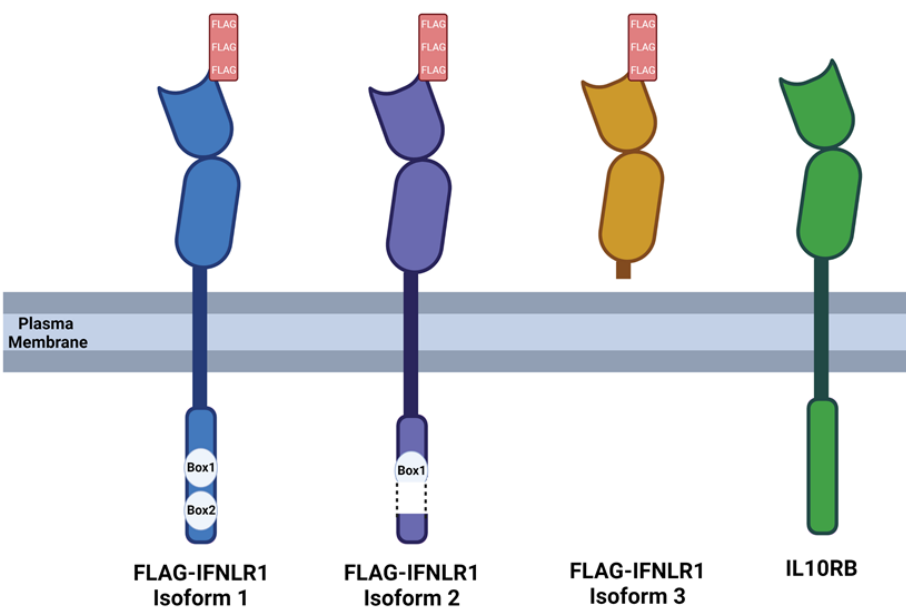
Figure 1. FLAG-IFNLR1 isoforms and co-receptor IL10RB. Schematic depicting the structure of each FLAG-tagged IFNLR1 isoform and IL10RB. Box1 and Box2 depict the Jak1 binding domain that is fully present in FLAG-IFNLR1 isoform 1, truncated in FLAG-IFNLR1 isoform 2, and absent in FLAG-IFNLR1 isoform 3. Image created with BioRender.com using default settings to represent a transmembrane protein.